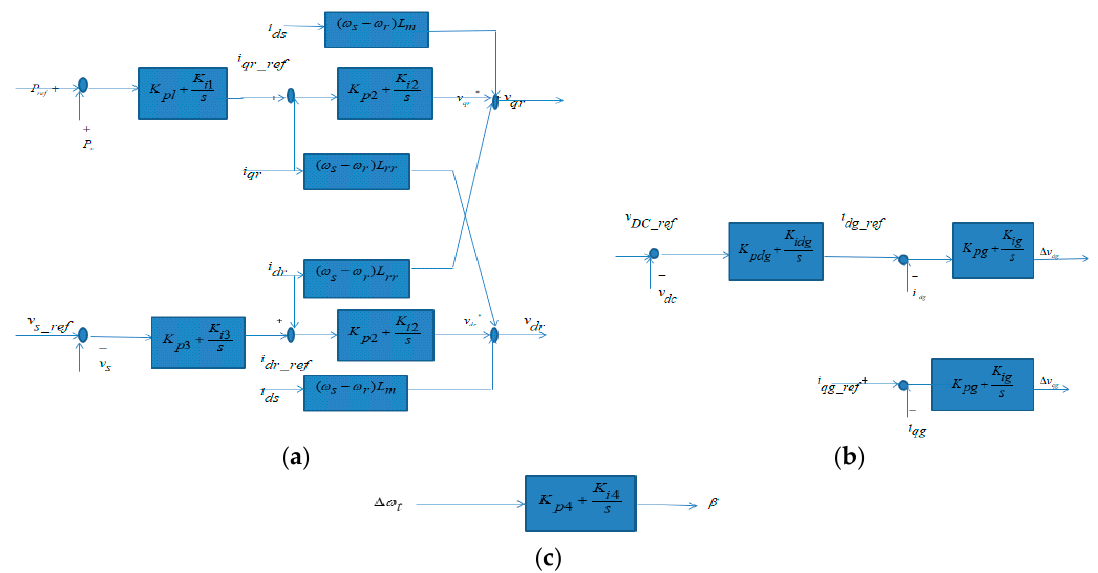
Figure 3. Control block diagram of DFIG with wind turbine (WT) ( a ) Rotor Side Converter (RSC) side, ( b ) Grid Side Converter (GCS) side, and ( c ) Pitch control [15].